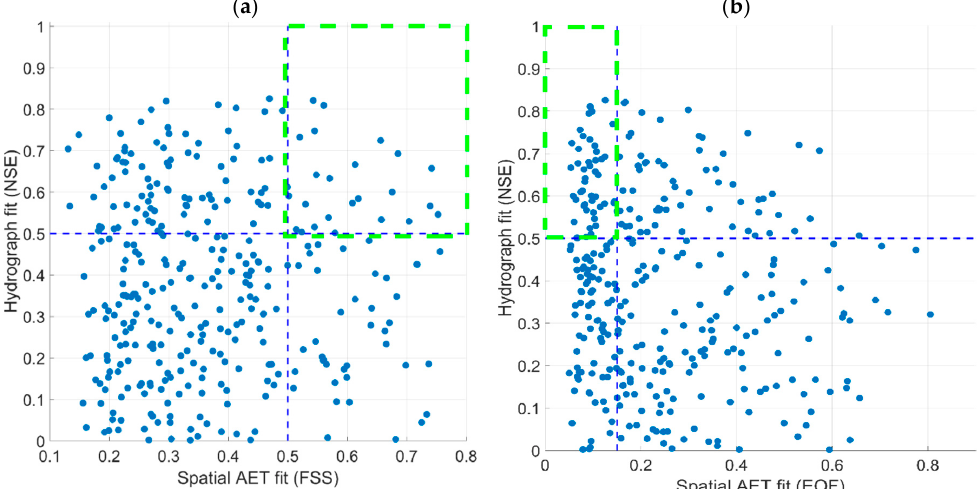
Figure 5. Scatter plot of 329 (NSE > 0.0) model runs from a total of 1700 random parameter sets as a function of spatial fit ( a ) FSS ( b ) EOF between remote sensing actual evapotranspiration and simulated actual evapotranspiration from mHM. Green box in both figures shows the new behavioral regions when spatial and temporal thresholds are applied together.